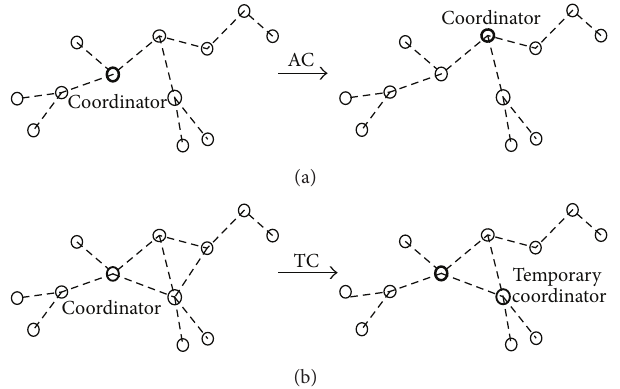
Figure 2: (a) Alternative coordinator. (b) Temporary coordinator.